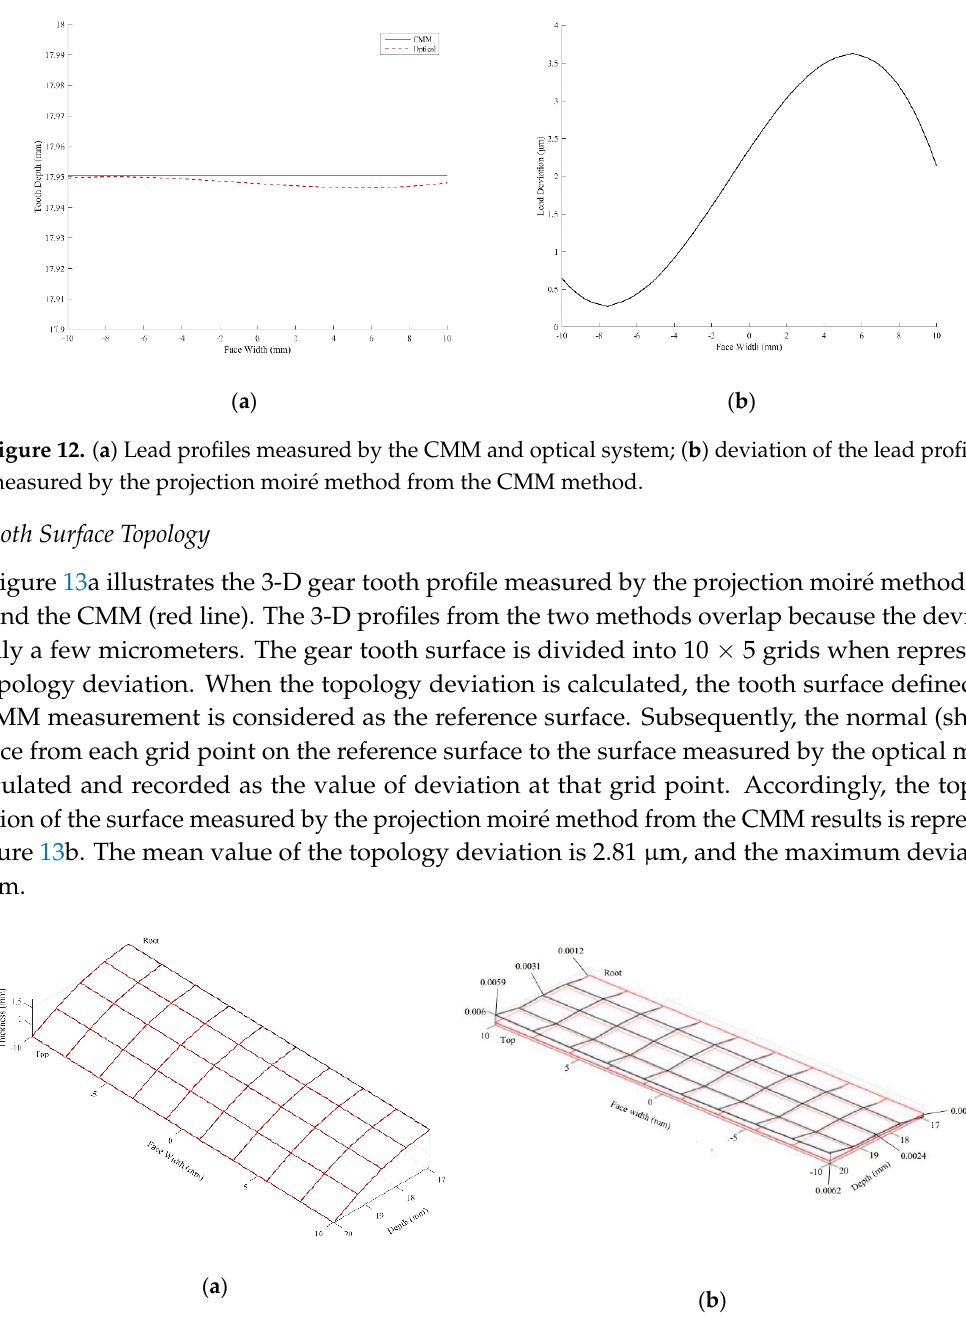
Figure 13. Spur gear tooth surface: ( a ) Topology of the gear tooth surface in 10 × 5 grids; ( b ) deviation of the tooth surface topology measured by the projection moir é system from the CMM